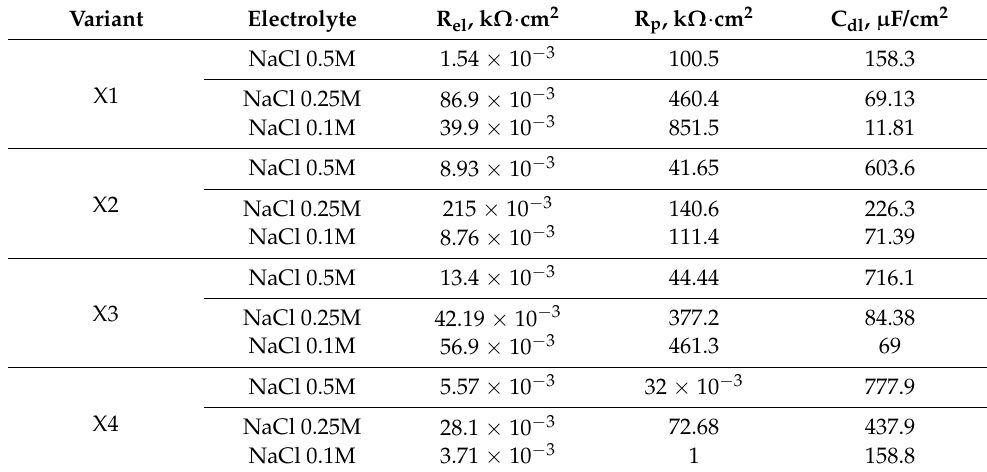
Table 3. EIS parameters for X1, X2, X3, and X4 CX-based electrode